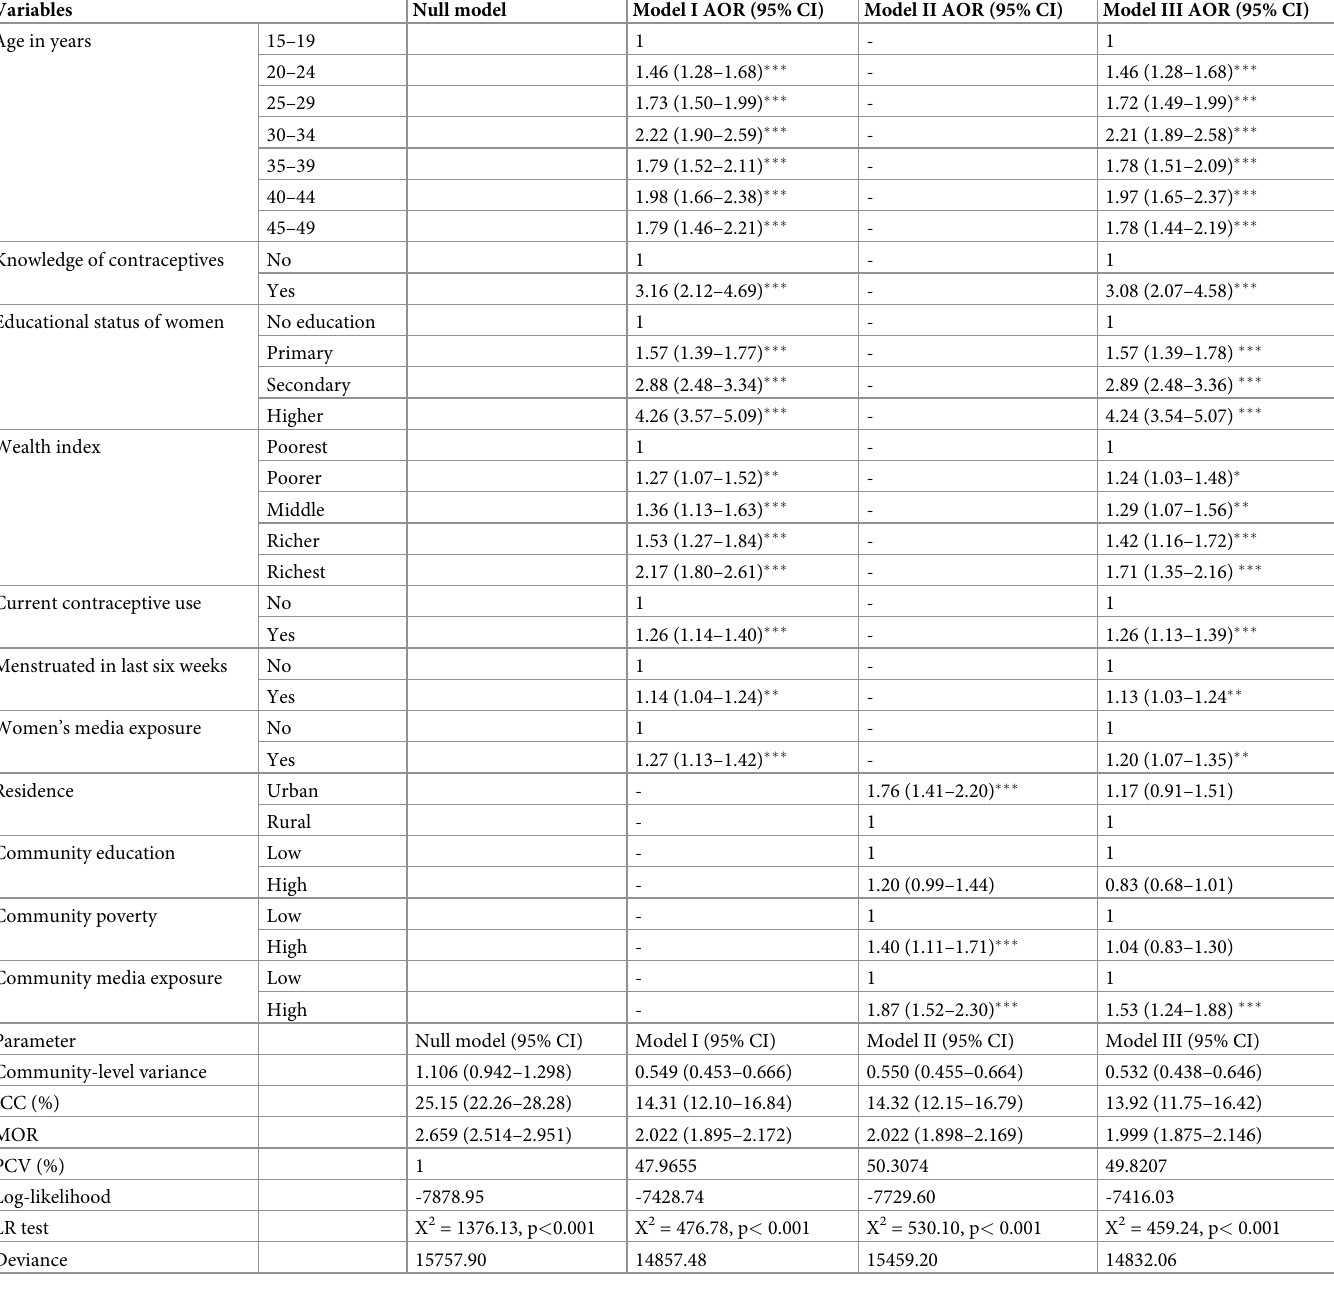
Table 2. Determinant factors of correct KOC among women of childbearing age in Ethiopia using multilevel logistic regression and the random-effects analysis (n =